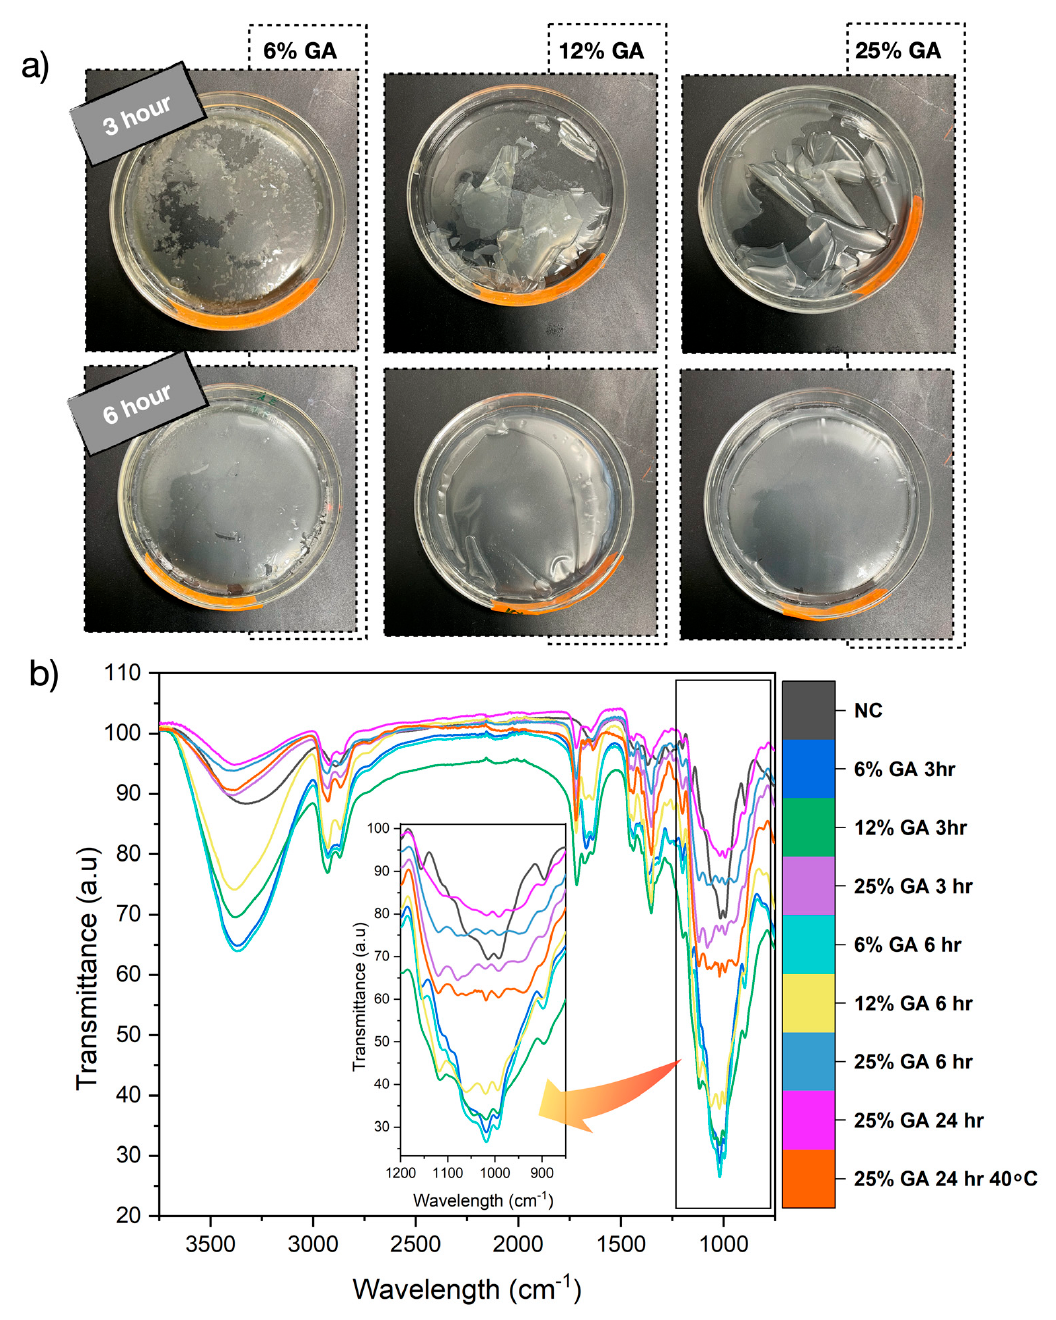
Figure 2. ( a ) Effect of crosslinker concentration and crosslinking time on the formation of crosslinked regenerated cellulose (CRC), ( b ) FTIR spectra of the networked-nanofibrous cellulose (NC) and the CRC films crosslinked with 6, 12, and 25% GA for 3, 6, and 24 hr all at curing temperature of 25 °C (room temperature), in addition to FTIR spectra at curing temperature of 40 °C. The inset represents the magnification of FTIR spectra between 1250–1750 cm − 1 wavelength.